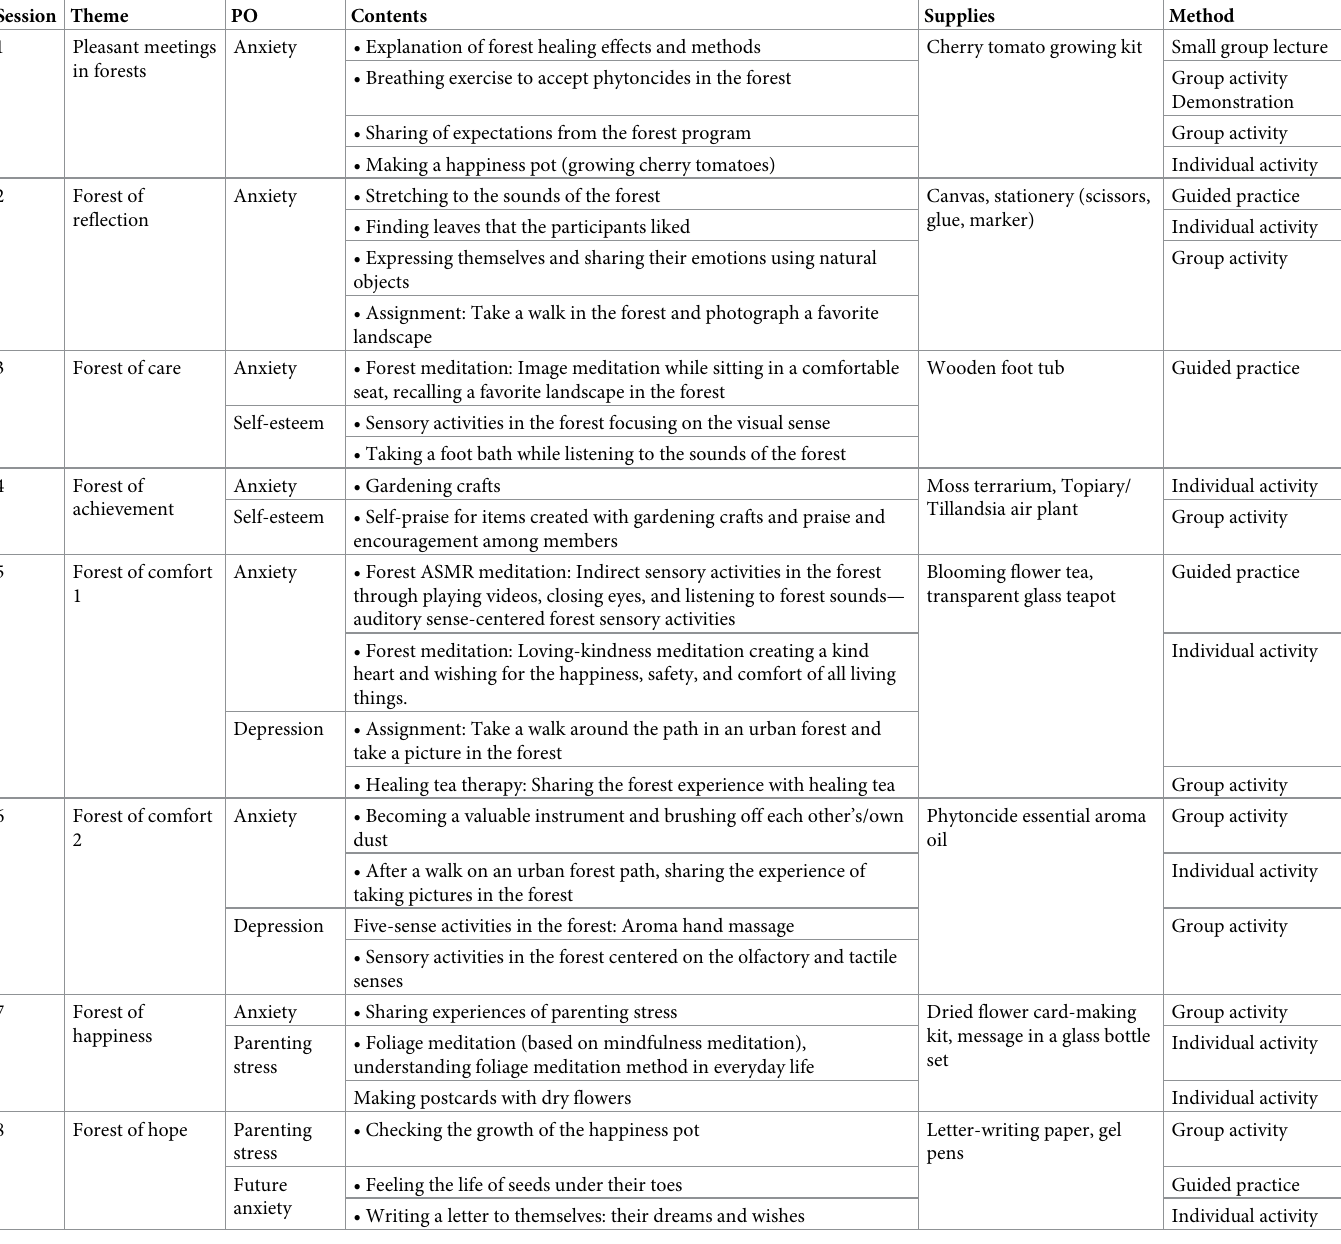
Table 1. Composition of each